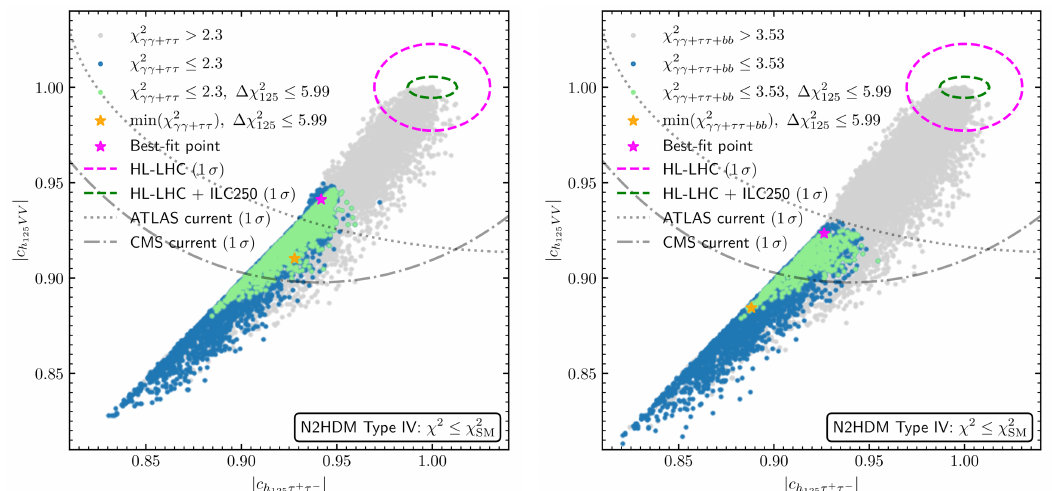
Figure 6 . The | c h | – | c h | plane for the parameter points discussed in section 4.1 in the 125 V V 125 ττ left plot and for the parameter points discussed in section 4.2 in the right plot, respectively. The grey points feature values of χ 2 > 2 . 3 (left) and χ 2 > 3 . 53 (right), whereas the blue γγ + ττ γγ + ττ + bb points feature χ 2 ≤ 2 . 3 (left) and χ 2 ≤ 3 . 53 (right). The green points are a subset of γγ + ττ γγ + ττ + bb the blue points that furthermore feature ∆ χ 2 ≤ 5 . 99 . The magenta and orange stars are defined 125 as in figure 3. Also shown are the current 1 σ uncertainties of the measurements of the coupling coefficients from ATLAS [77] and CMS [78] indicated by the dotted and the dash-dotted lines, respectively. The magenta and the green ellipse indicate the prospects for these uncertainties after the high-luminosity phase of the LHC [79] and after a hypothetical ILC run at a center-of-mass energy of 250 GeV , respectively